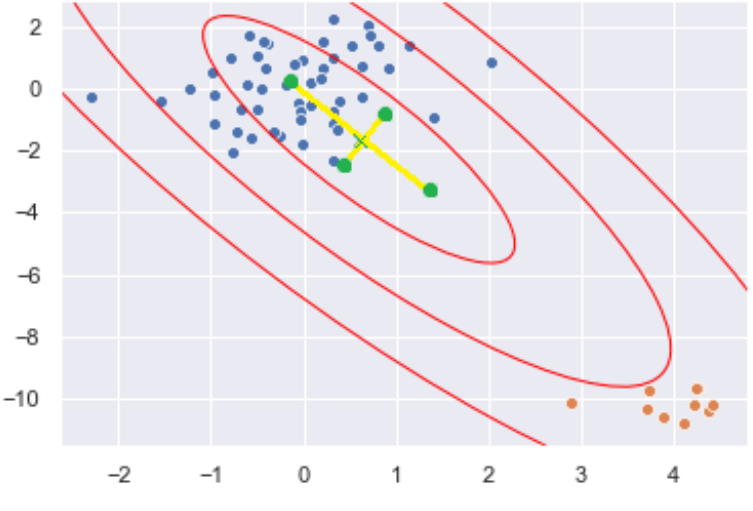
Figure 6. Cardinal directions of shifts (yellow lines) of the centroid (green cross) in 2D.